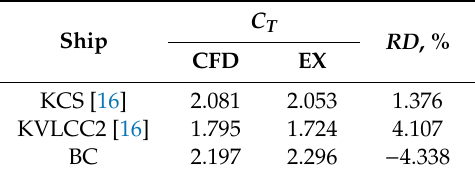
Table 10. The validation study for C T